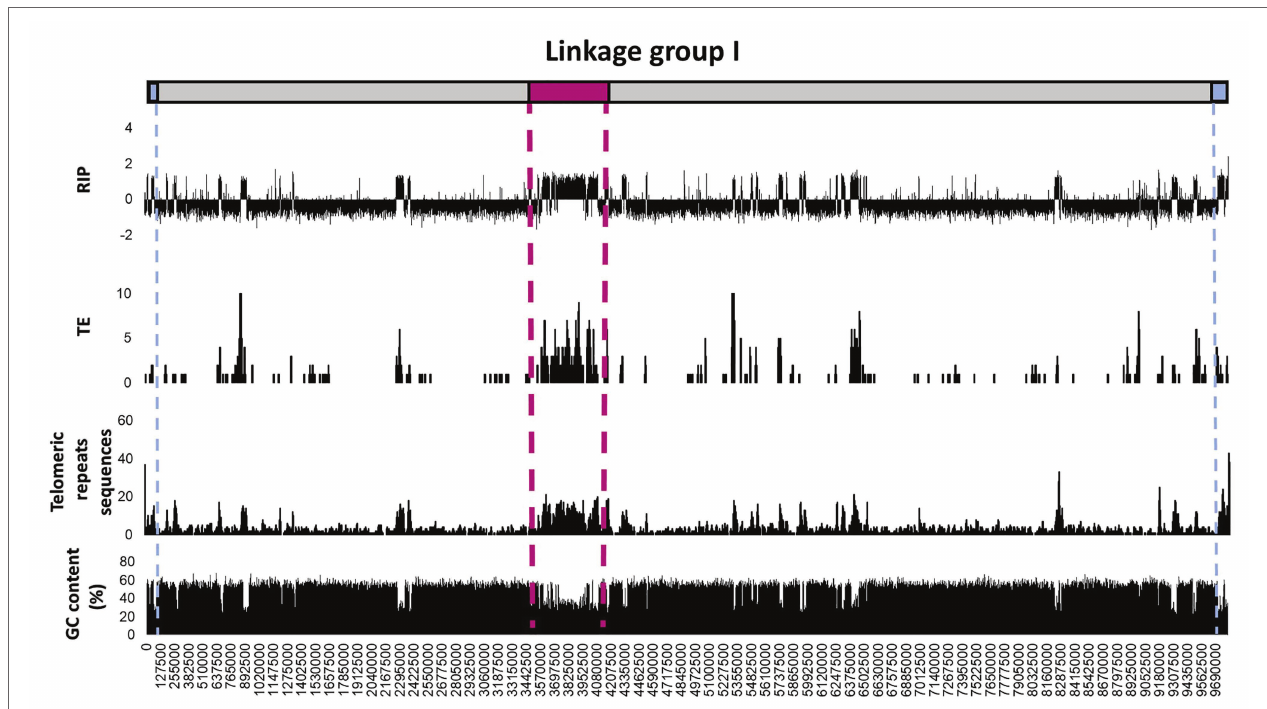
FIGURE 3 | Distribution of RIP mutations, TEs, telomeric repeats, and GC content across the first linkage group/chromosome of Neurospora crassa . The putative positions of telomeres and the centromeres are shown in blue and pink, respectively. The RIP graph depicts changes in the RIP composite index across the length of the chromosome, where values above 0 are indicative of RIP. Only the number of TEs or TE-related repeats larger than 100 base pairs (bp) are shown and were calculated using 10 Kbp windows with 5 Kbp increments. The telomeric repeat (TTAGGG/CCCTAA) frequency was calculated for every 10 and 5 Kbp increments. Changes in GC content were determined using a 1,000 bp window and 500 bp increments. See Supplementary Figure S2 for corresponding information for the remainder of the linkage groups/chromosomes of this